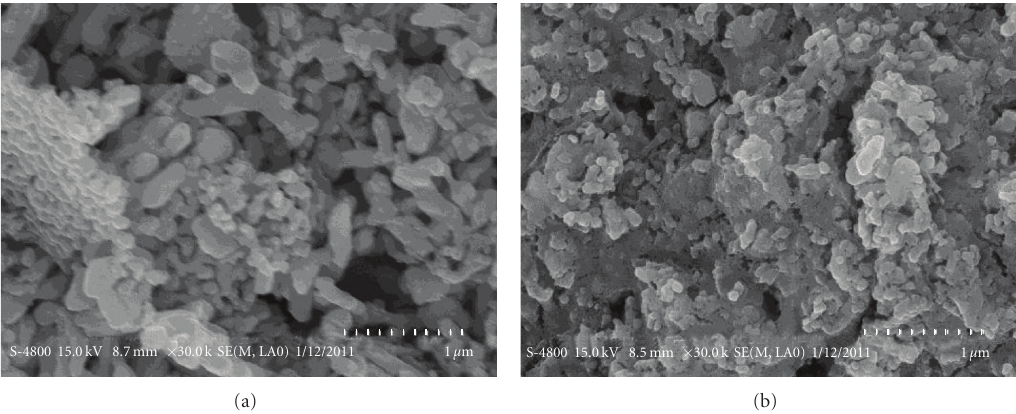
Figure 2: SEM micrographs the thin film. (a) Bi 4 Ti 3 O 12 top view, (b) TiO 2 coated Bi 4 Ti 3 O 12 .